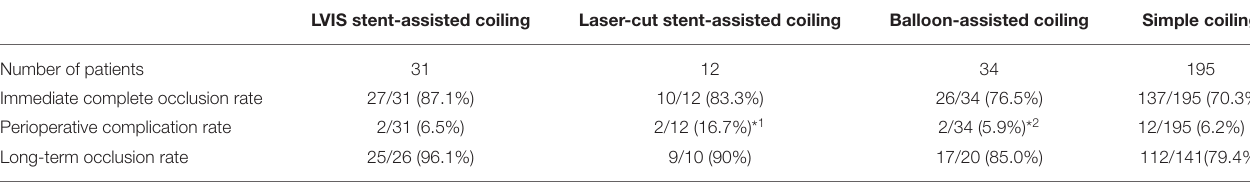
TABLE 1 | Results of different methods used for the treatment of ruptured ACoA